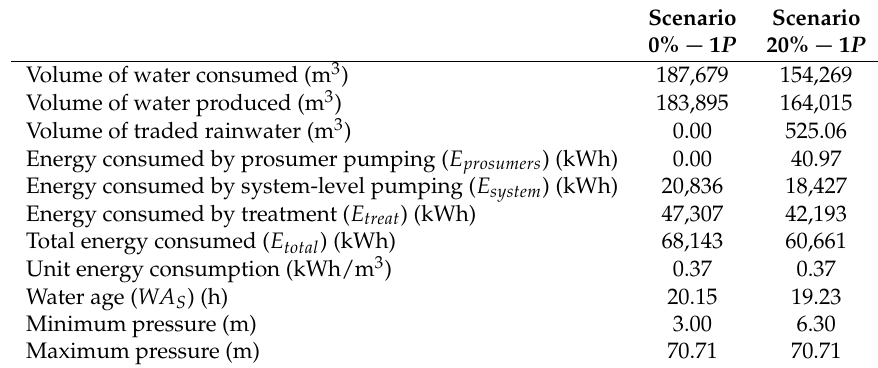
Figure 6. EPANET output reports flow of water produced by the treatment facility and flow of water consumed at nodes for Scenario 20% − 1 P . Table 3. Metrics reported for Scenarios 0% − 1 P and 20% − 1 P